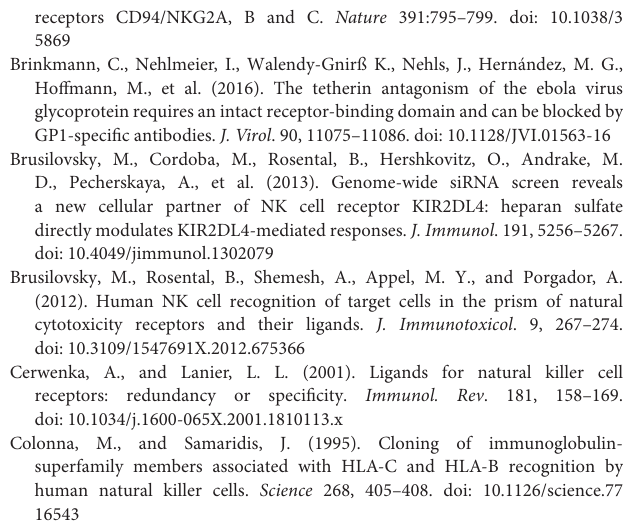
Figure S1 | Schematic illustration of GP Glycosylation sites and design of mutations. (A) Illustration showing the design of mutants. Codon alteration is noted over the amino acid sequence. N-Glycosylation sites are highlighted in yellow and altered amino acids are highlighted in red. (B) Glycosylation sites of the MLD and GCD domains; N-Glycosylation sites are marked with the “Y” mark. (C) WB analysis of HEK293T cells; cells were transfected with either WT GP or GP mutants. Glycosylation loss caused change in migration pattern. Figure S2 | (A) Overlay of WT/mutant GP transfected HEK293T cells stained with biotinylated anti GP Ab and streptavidin AF647. (B) Overlay of WT/mutant YFP fused GP transfected HEK293T cells. (C) Linear correlation between YFP-fused wild type GP and glycan deletion mutants of GP. HEK293T cells were transfected with wild type GP or with glycan deletion mutants of GP created by site directed removal of N-Glycosylation sites (MLD, GCD or both domains). Thirty hours post transfection, cells (without fixation or Permeabilization) were stained with a biotinylated 3C10 anti GP antibody ( Edri et al., 2018), followed by allophycocyanin-conjugated streptavidin. Panels show the YFP-conjugated glycan deletion mutants of GP and the YFP-conjugated wild type